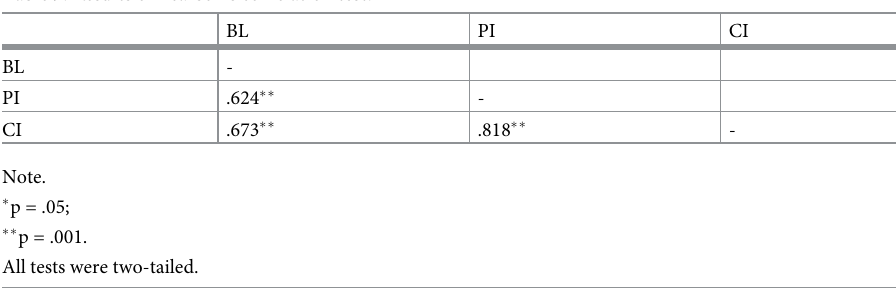
Table 9. Results of Pearson’s correlation test.